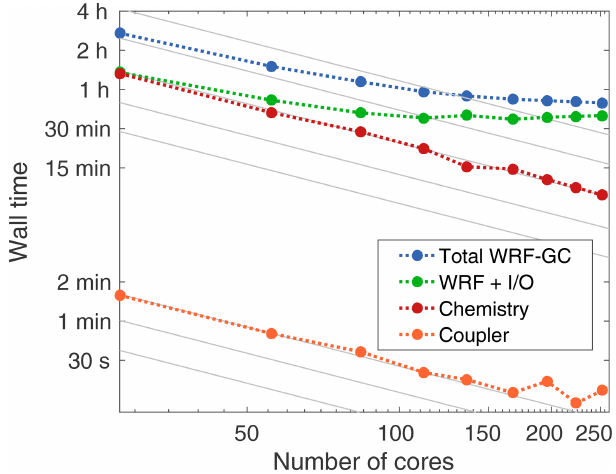
Figure 7. WRF-GC model scalability by processes. Grey lines in- dicate perfect scalability, i.e. halved computational time for each doubling of processor